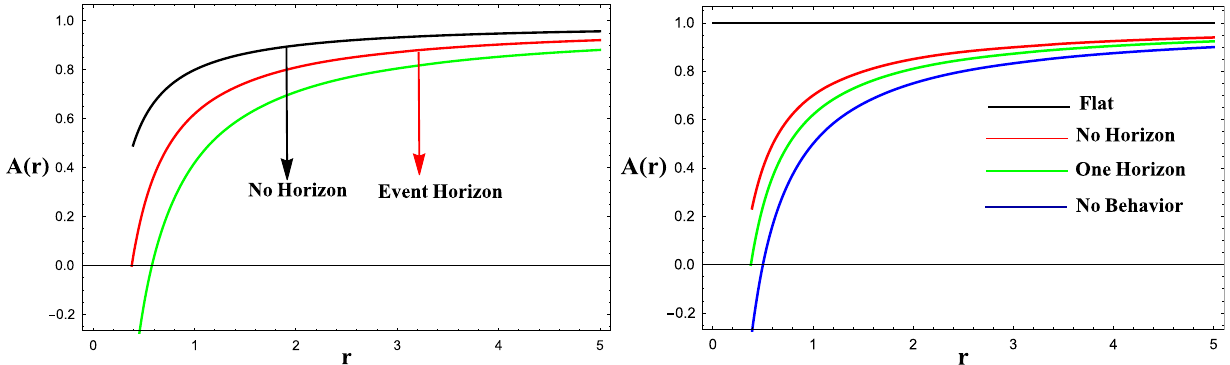
Fig. 2 The horizon structure of Schwarzschild–de Sitter BH (left panel) and Schwarzschild BH (right panel) display the behavior of A ( r ) versus r . The horizon curves of Schwarzschild–de Sitter BH are obtained for β = 0 . 10 , 0 . 19 , 0 . 29 and other parameters are taken as